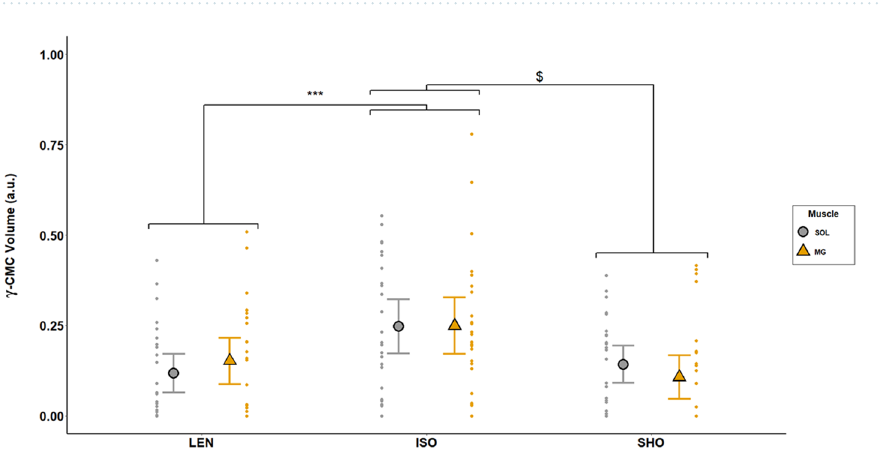
Figure 5. Effects of muscle contraction type on gamma-band CMC. CMC was computed as the volume in the gamma-band (33–52 Hz) during the last 200 ms prior to the neurostimulation onset. Modulations are shown in the soleus (grey circles) and the medialis gastrocnemius (yellow triangles) during lengthening (LEN), isometric (ISO) and shortening (SHO) contractions. Error bars represent the 95% CI of the mean (n = 25). Lengthening vs isometric: ***p < 0.01; shortening vs isometric: $ p <